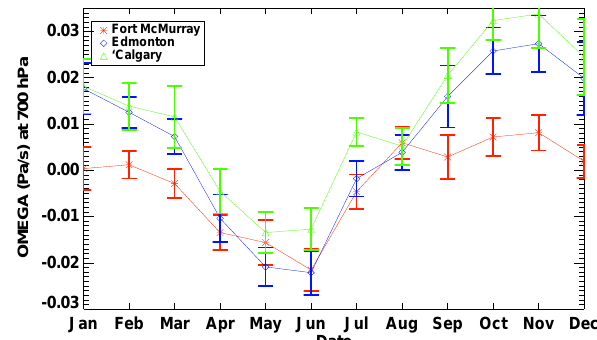
Figure 6. Omega averages at 700hPa from 2002 to 2013.